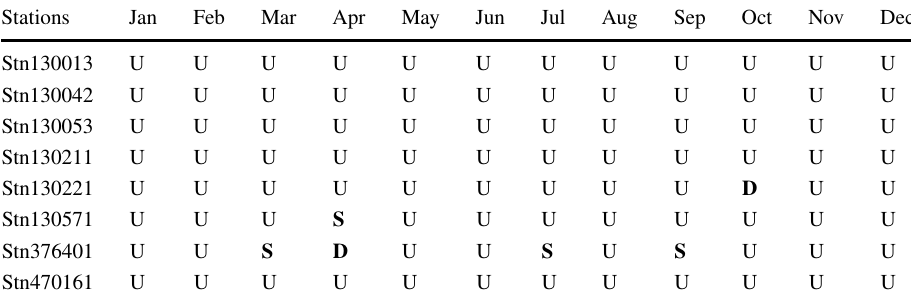
classification of each calendar month and station based on the